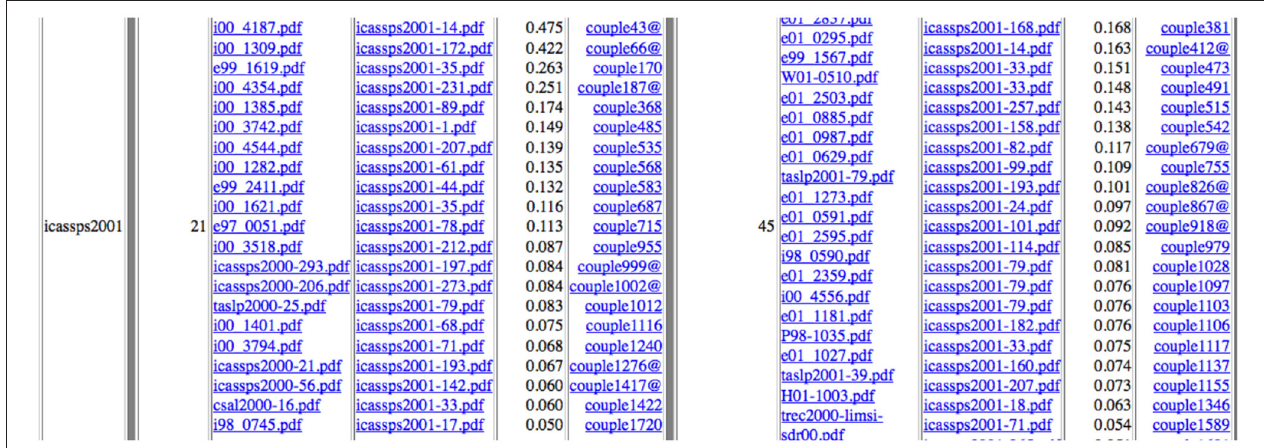
FIGURE 23 | Example of ICASSP 2001 Speech papers self-reusing ( left : 21 cases identified) and self-plagiarizing ( right : 45 cases identified) other papers with similarity scores (@ following the couple number indicates that the two papers have the same full list of authors).